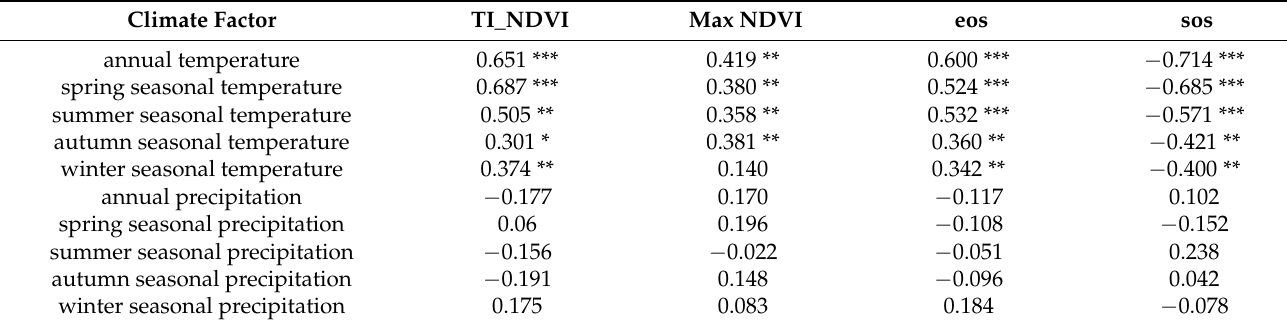
Table 4. The relationships between NDVI metrics and climate factors (sos: start of season, sos: end of season. *** p < 0.001; ** p < 0.05; * p < 0.1).